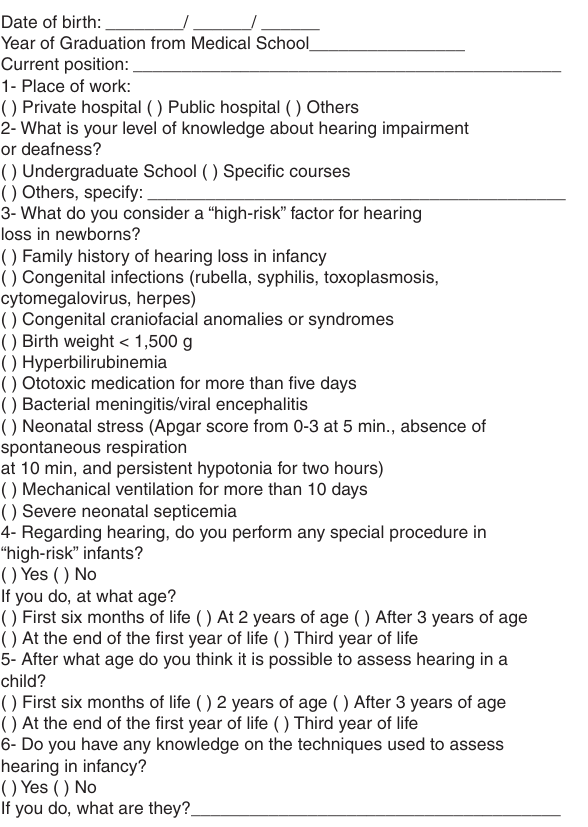
Questionnaire used in the